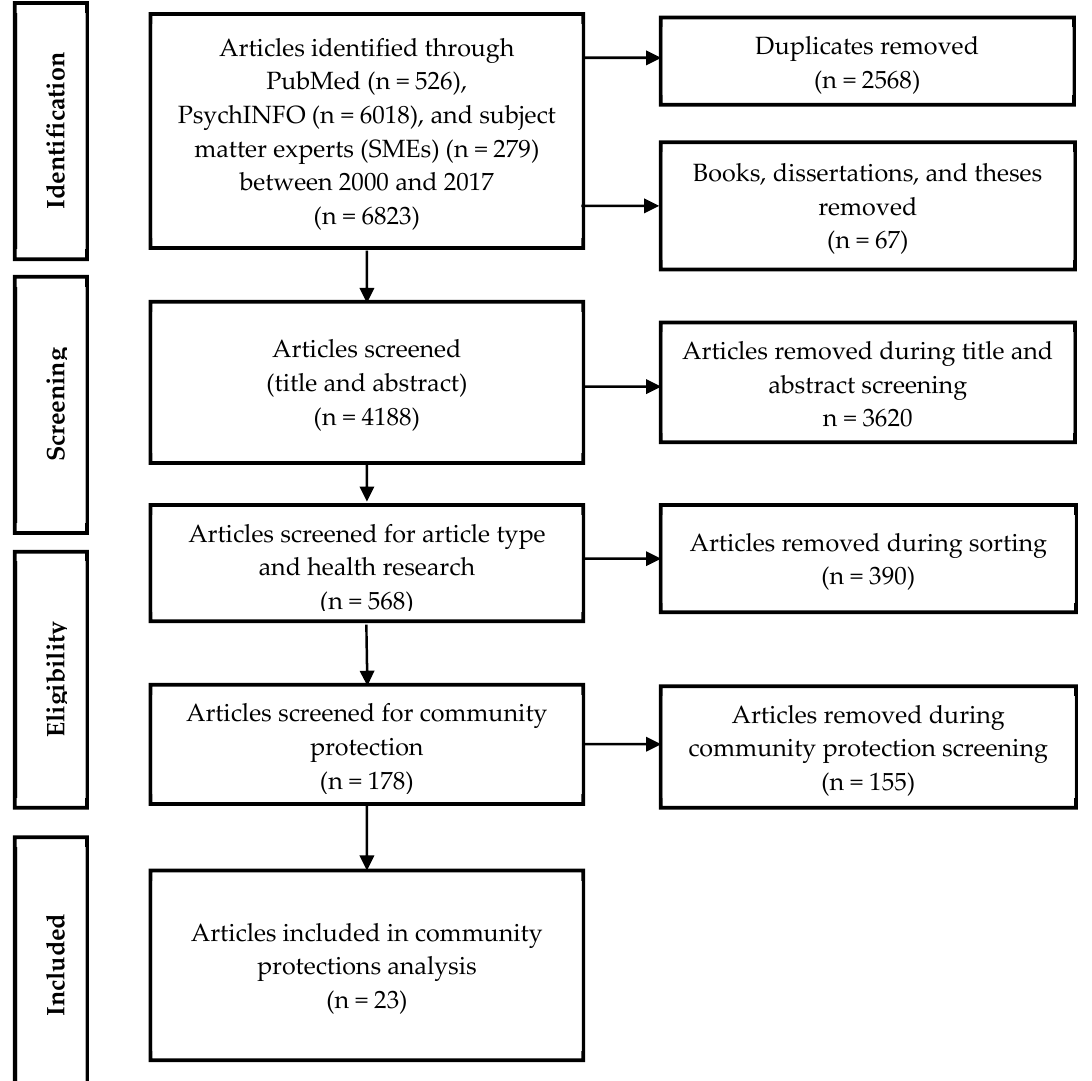
Figure 1. Article selection flow chart.